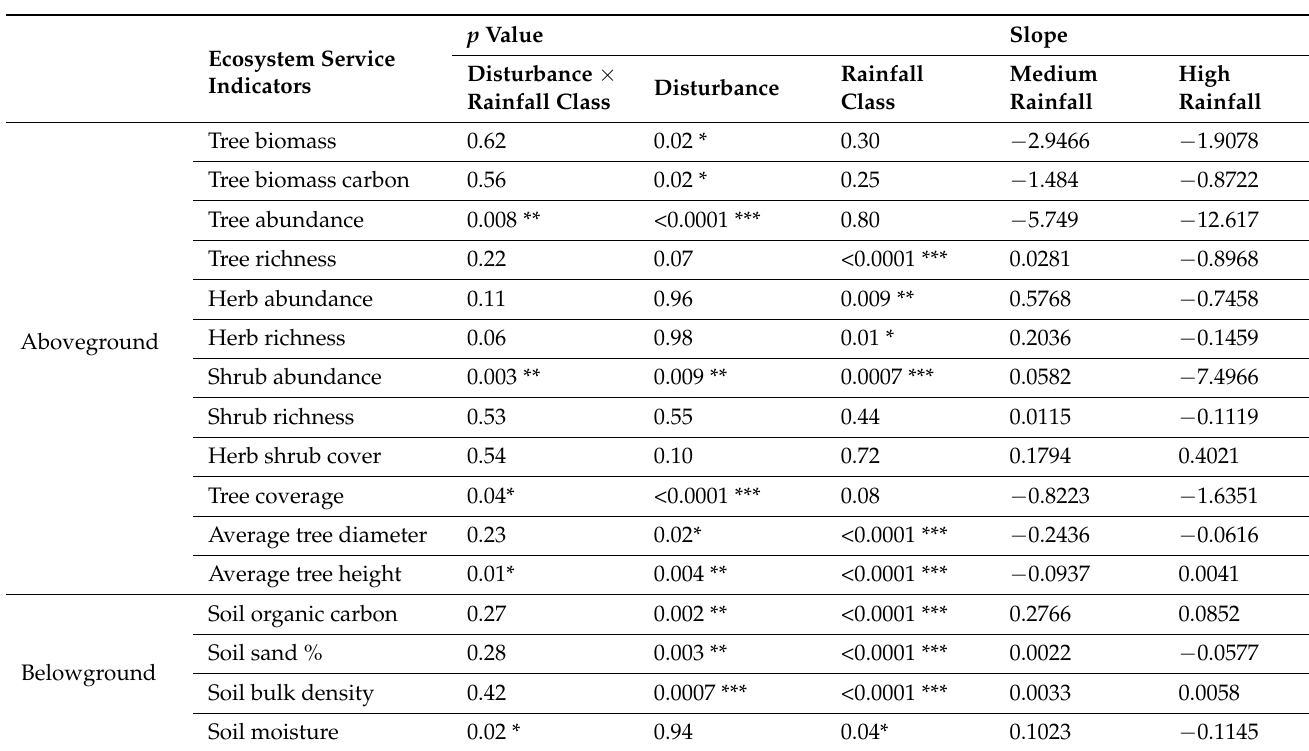
Table 2. p value and slope extent of precipitation and disturbance effects on ecosystem services under different rainfall regimes in our study sites in Northeast Bangladesh. Significant codes: 0.0001 = ‘***’; 0.001 = ‘**’; 0.05 =